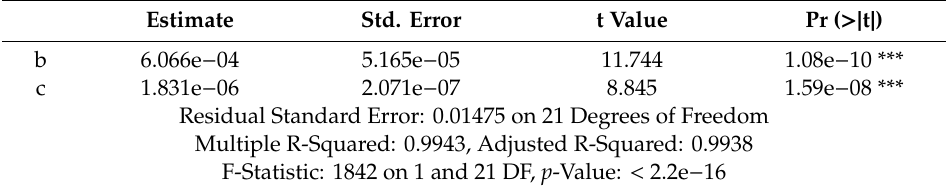
Table 8. Statistical parameters for the polynomial regression